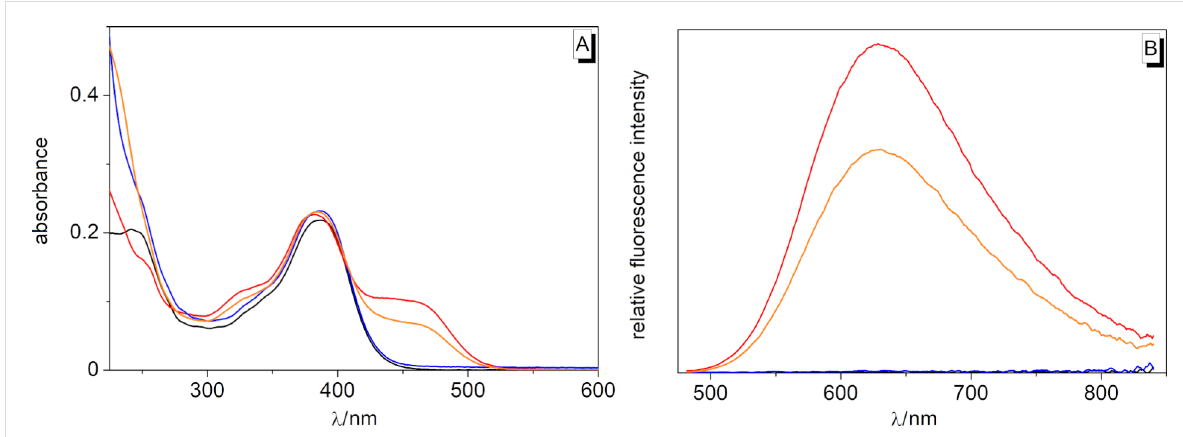
Figure 3: Absorption (A) and fluorescence spectrum (B) of 3a in MeCN ( c = 5 µM) in the absence (black) and in the presence of metal ions ca. 1 h after the addition. Red: Cu 2+ ( c = 15 µM), orange: Hg 2+ ( c = 100 µM), blue: Li + , Na + , K + , Mg 2+ , Ca 2+ , Mn 2+ , Fe 2+ , Co 2+ , Ni 2+ , Zn 2+ , Ag + , and Pb 2+ ( c = 100 µM each); λ ex = 470 nm.